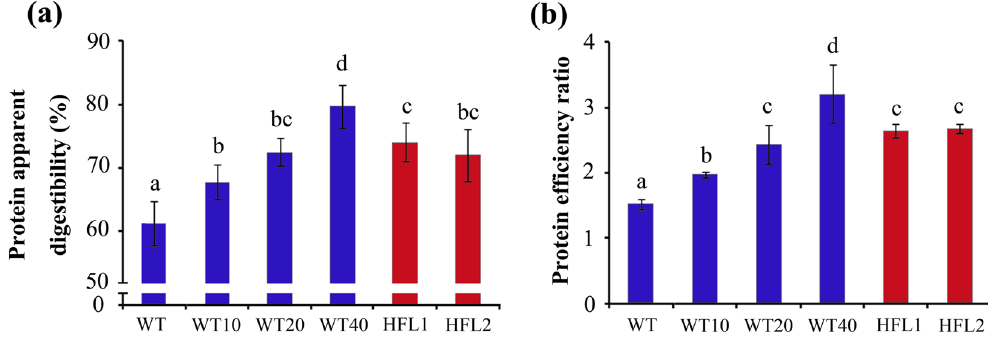
Figure 4. Protein apparent digestibility ( a ) and protein efficiency ratio ( b ) of rats fed different diets. Error bars represent SD (n = 8). Different letters represent significant differences ( P <